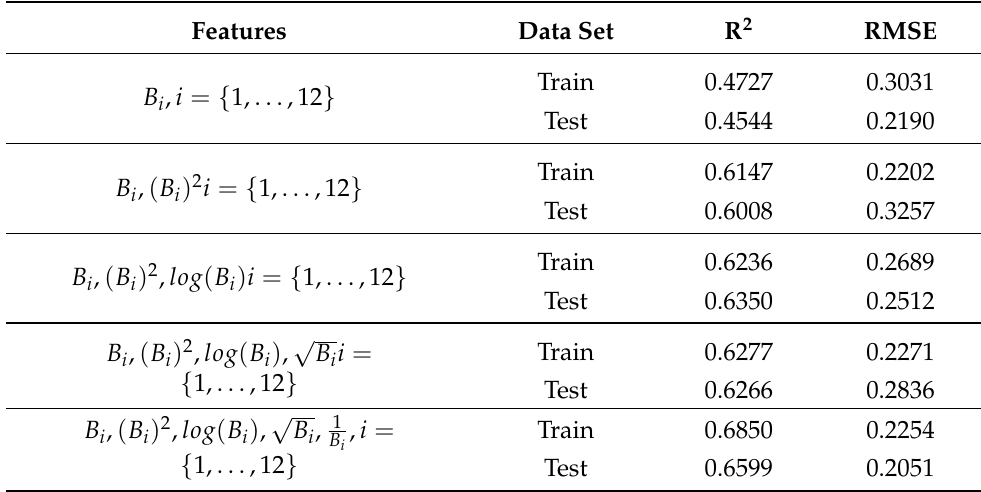
Table 5. Analysis of Ridge regression performance on different features, where B i represents a value of each Sentinel-2 band (B01-B09, B8A, and